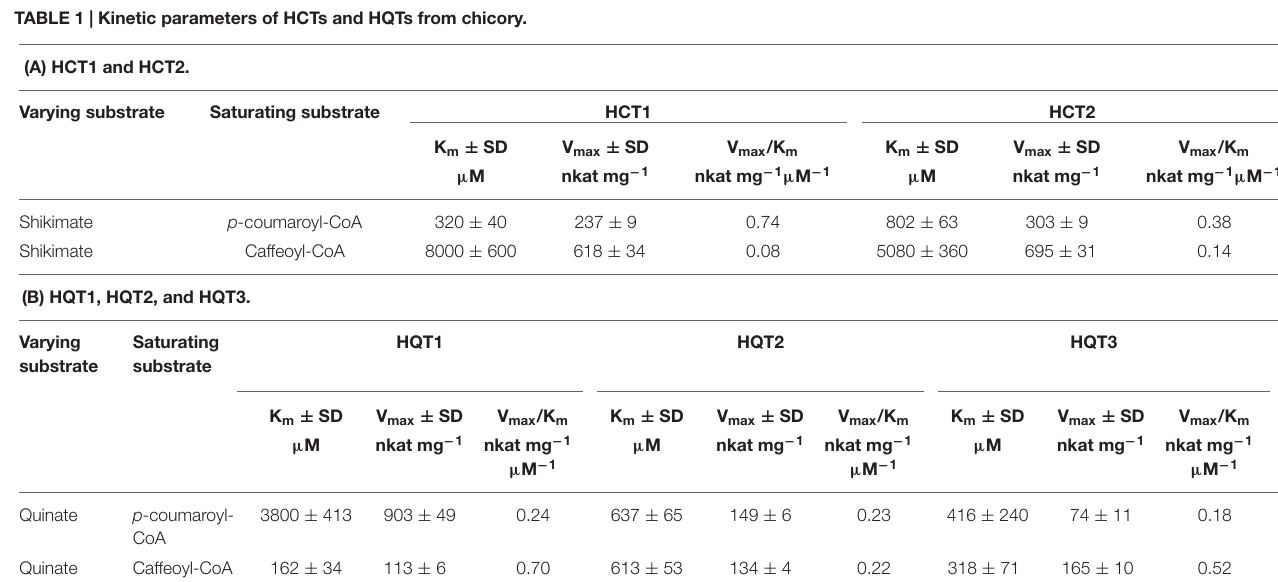
(Niggeweg et al., 2004). N. benthamiana plants were co- infiltrated with A. tumefaciens containing constructs of HCT1 (or HQT1) or the p19 gene. As control, leaves were infiltrated with the p19 vector only or the empty pB2GW7 vector (see Materials and Methods for the details). After 4 days, leaves were collected and the amounts of CQA measured.